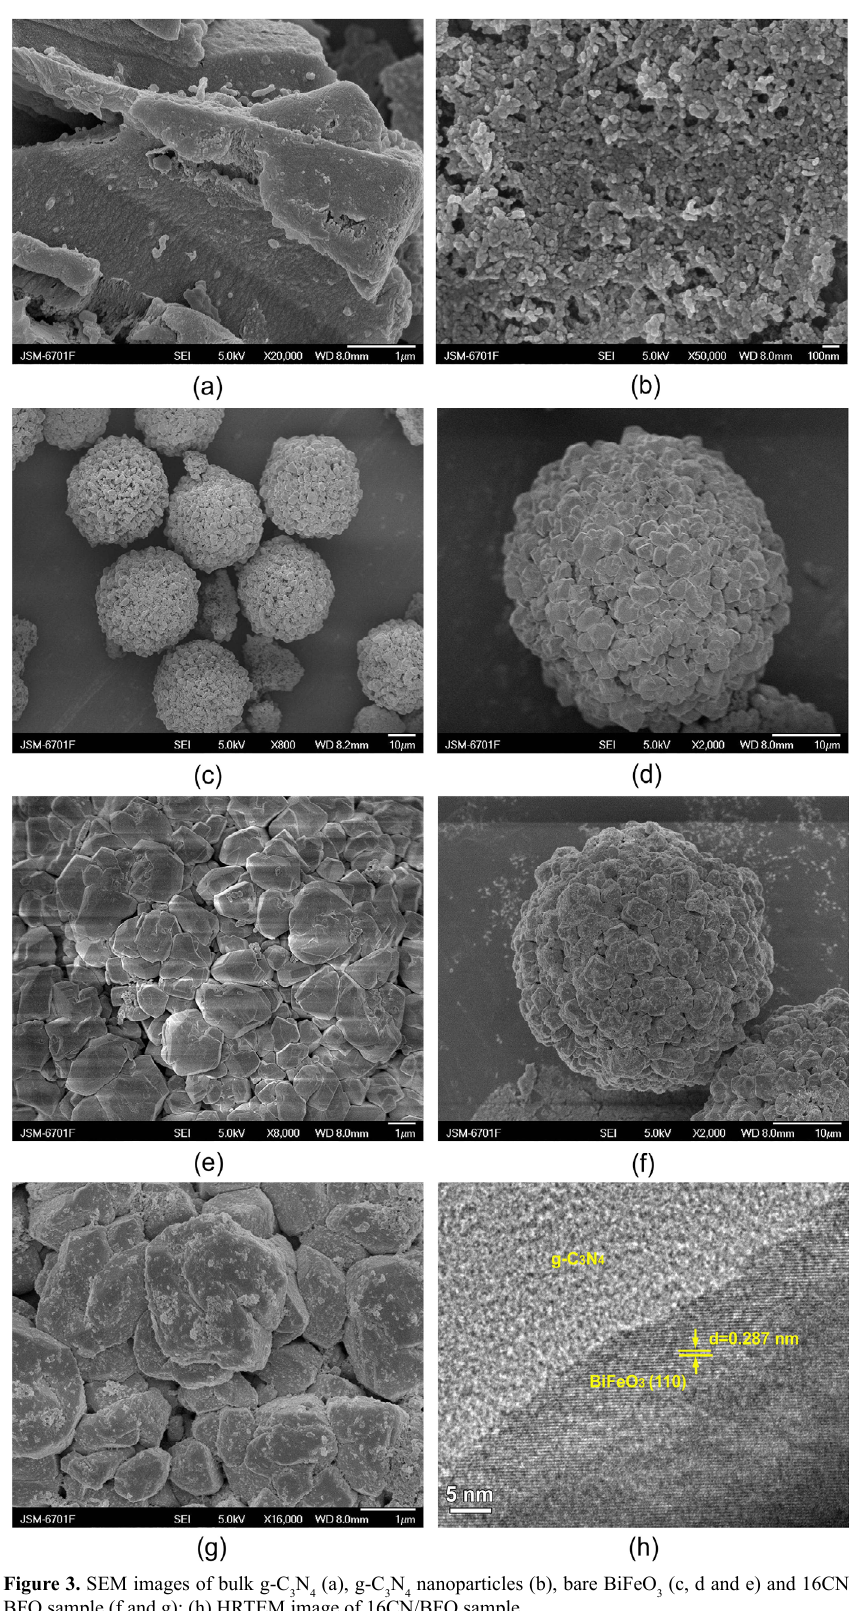
Figure 3. SEM images of bulk g-C BFO sample (f and g); (h) HRTEM image of 16CN/BFO